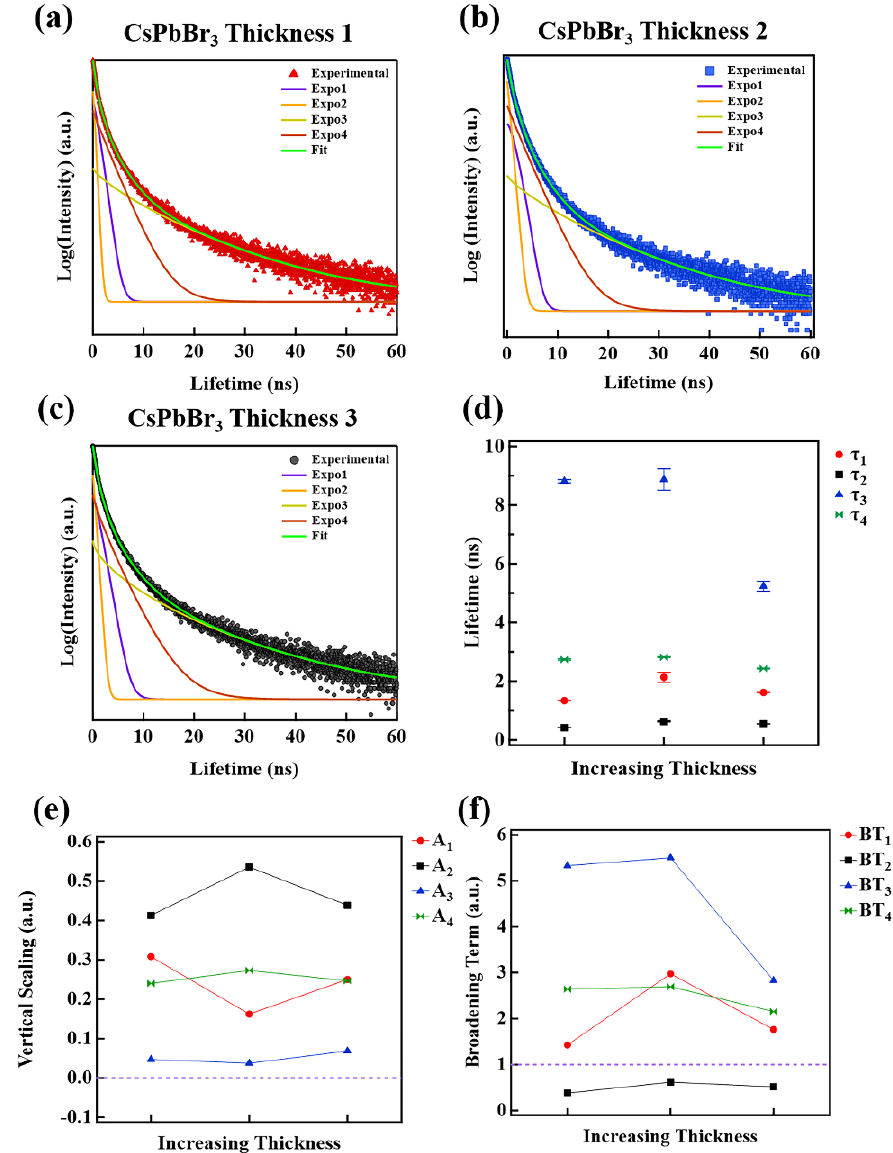
Figure 5. ( a ) TRPL spectra for single-layer method of CsPbBr 3 films of thickness 1, ( b ) thickness 2 and ( c ) thickness 3, such that thickness 1 < thickness 2 < thickness 3; ( d ) the extracted time constants vs. layer thickness; ( e ) vertical scaling constants vs. layer thickness; and ( f ) broadening term vs. layer thickness.